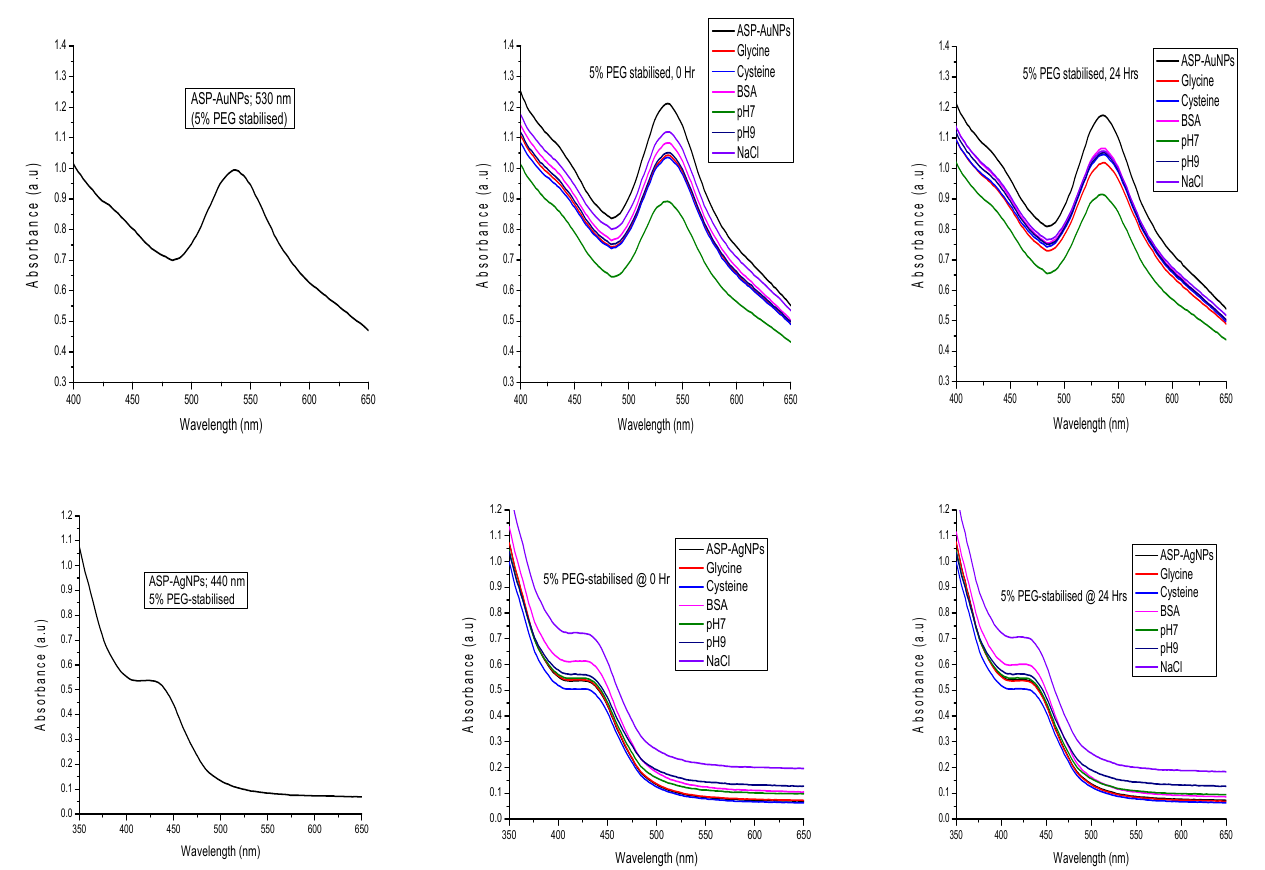
Figure 7. In vitro stability of PEG-stabilised ASP-AuNPs and ASP-AgNPs in biogenic